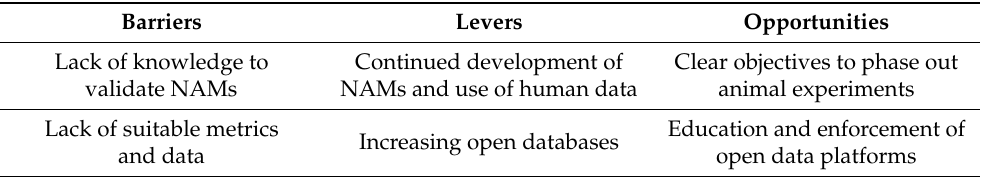
Table 1. Barriers, levers, and opportunities at the niche